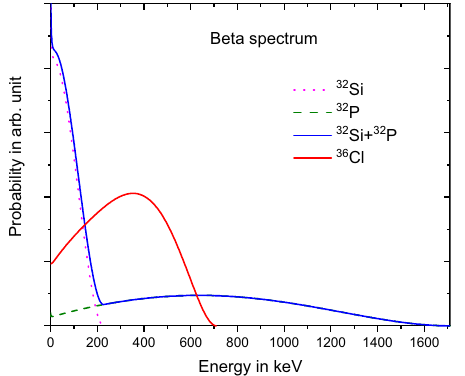
Figure 3. Beta emission spectrum of 32 Si, 32 P, 32 Si + 32 P in secular equilibrium, and 36 Cl calculated from theory 34 . The measured spectra in the gas detector are degraded by energy loss and absorption of electrons in materials.